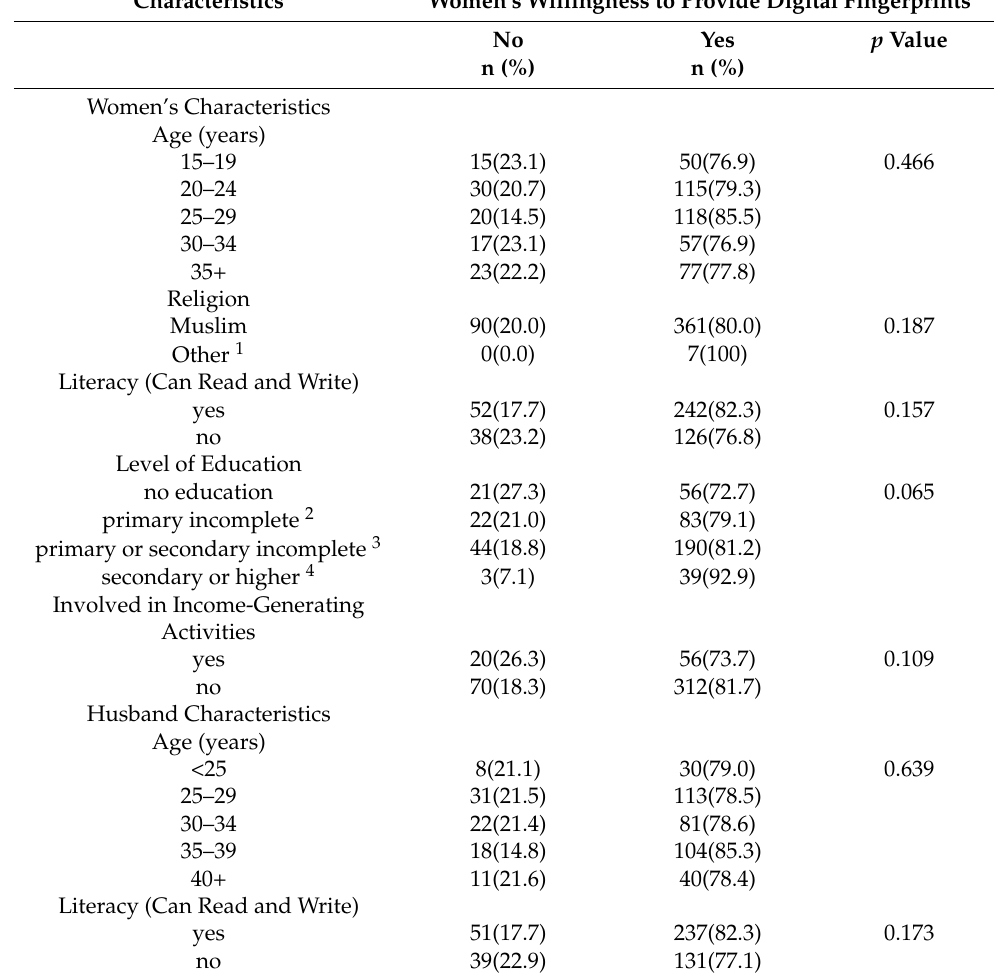
Table 3. Bivariate analysis of sociodemographic characteristics of women and their willingness to provide digital fingerprints (N =